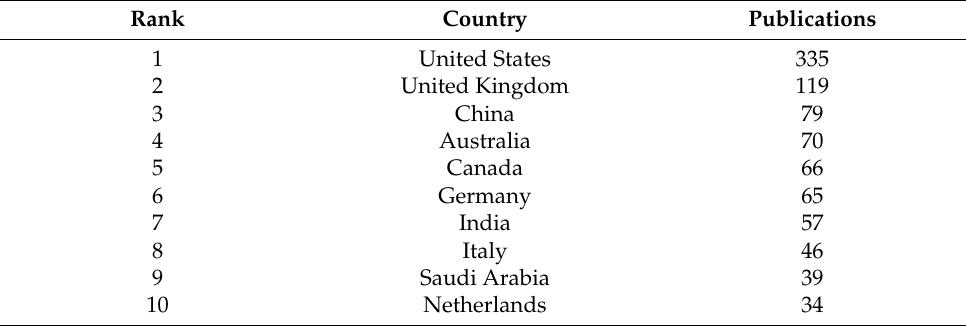
Table 2. Top 10 countries by the number of